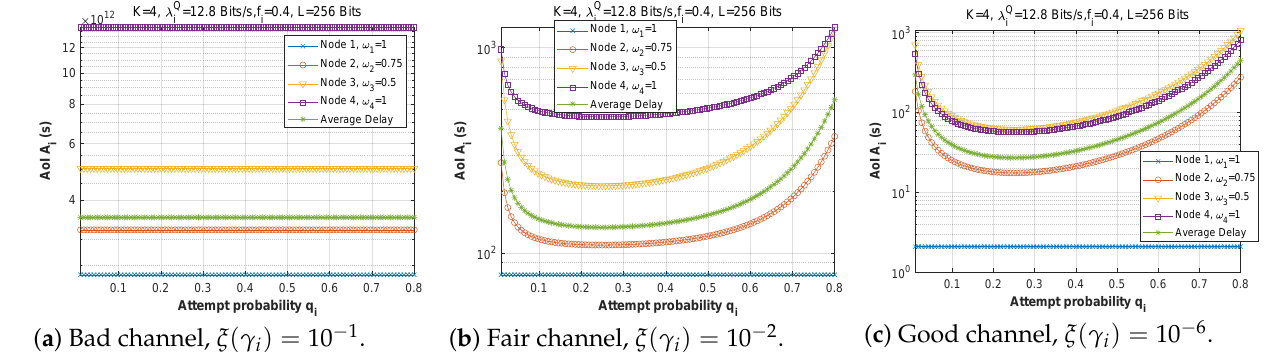
Figure 26. Setting 2: The AoI experienced at each mobile device as a function of attempt probability for various bit error rates ξ ( γ i ) .